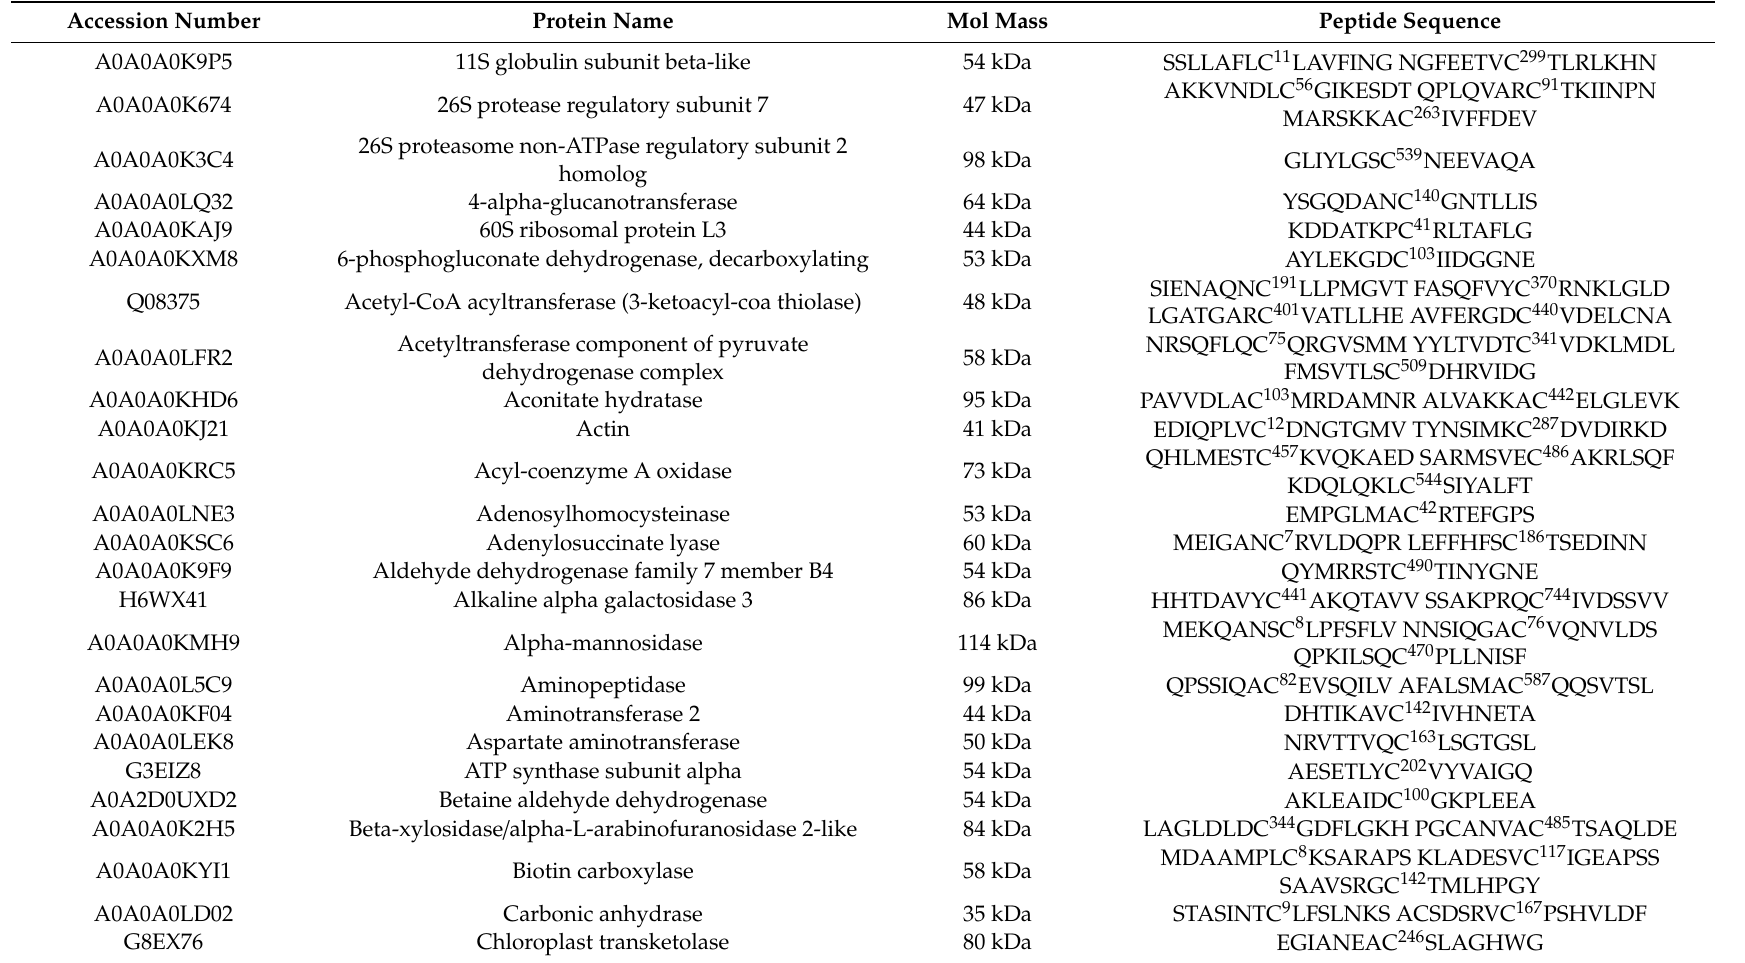
Table 1. S -nitrosylated proteins identified from the control, S-nitrosoglutathione (GSNO), and GSNO + 2-(4-carboxy-2-phenyl)-4, 4,